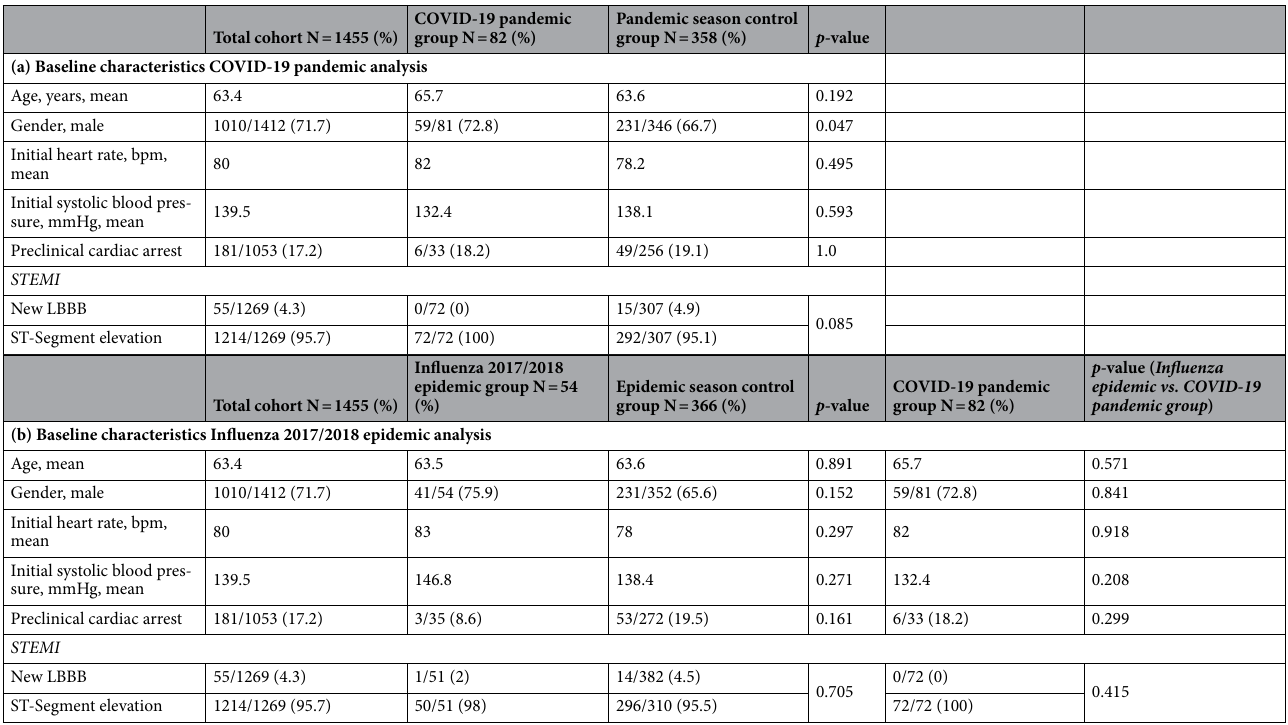
Table 1. Baseline characteristics. STEMI ST-segment elevation myocardial infarction, LBBB left bundle branch